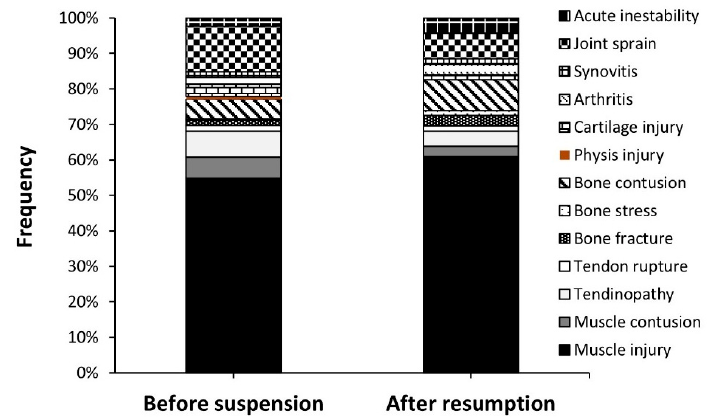
Figure 2. Distribution of lower limb injuries in professional football players before the suspension of LaLiga due to the COVID-19 pandemic and after the resumption of the competition. In the resumption of the competition, there was no change in the distribution of in- juries according to their mode of onset, presence of contact, or condition, and it did not affect the distribution of injuries among playing positions (Table 2). However, there was a tendency for a higher frequency of injuries that required only 1–7 days to return to play after the resumption of the competition, while the proportion of severe injuries (i.e., more than 28 days of recovery) was reduced. Finally, the distribution of injuries according to their type was not affected by the resumption of the competition (Figure 3; p = 0.766).